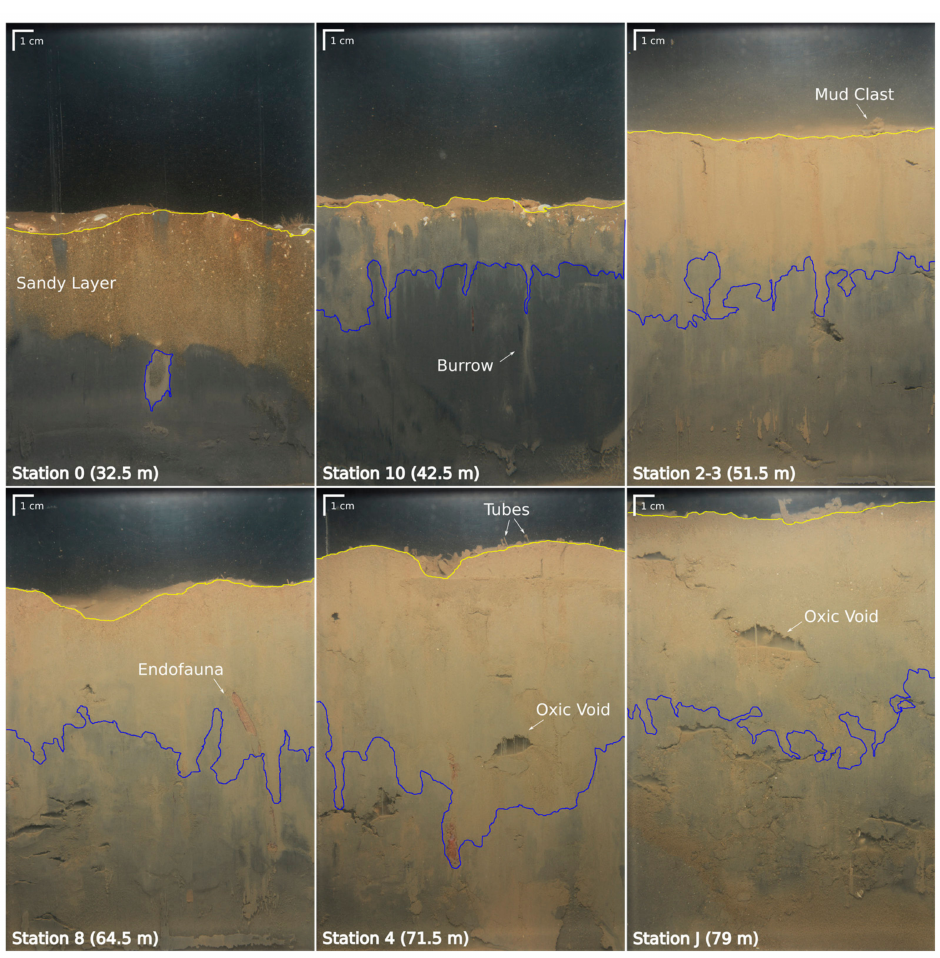
Figure 6. Examples of Sediment Profile Images (SPI) collected at six stations located along the depth gradient sampled for X-rays radiographies (see Figure 1). Yellow lines represent sediment– water interfaces and blue lines represent apparent Redox Potential Discontinuity (aRPD) thicknesses. Stations are the same as in Figure 5, and codes are the same as in Figure 1 and Table